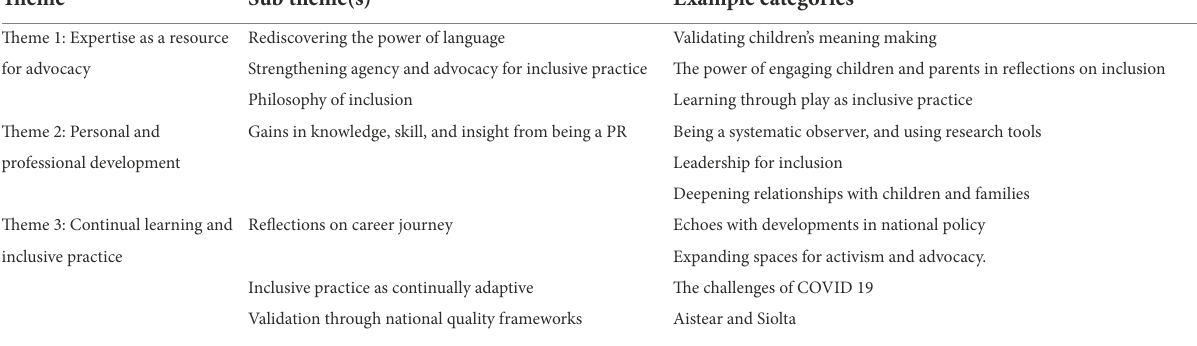
TABLE 1 Thematic analysis: summary of themes, subthemes, and categories. Theme Sub